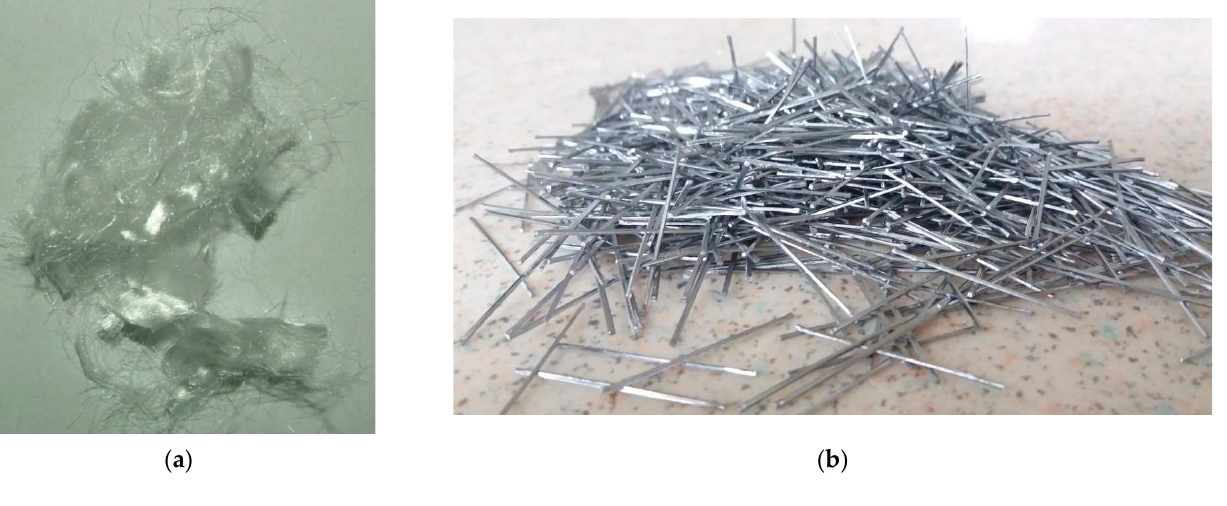
Figure 3. Fibre types: ( a ) polypropylene (PP) with a length of 18 mm, ( b ) 25/0.4 steel.